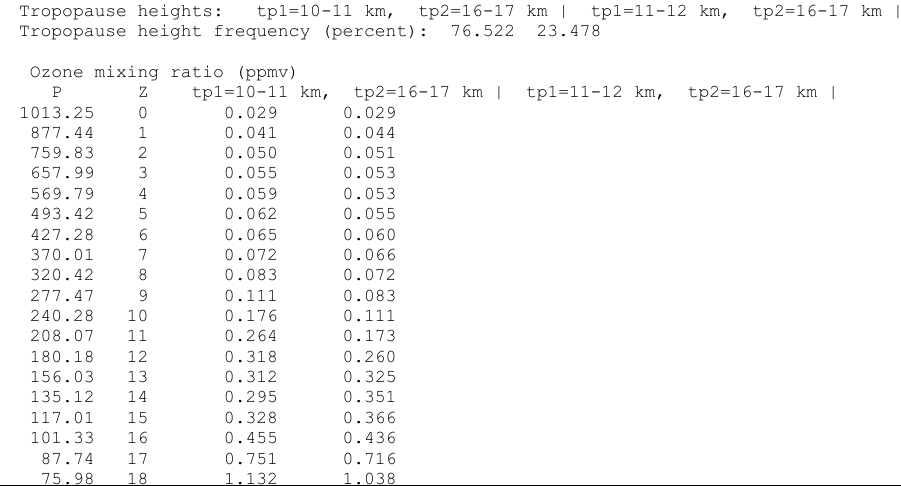
Fig. 16. An example of the records in the ASCII file for double-tropopause cases. “tp1” and “tp2” denote the first and the second tropopauses, respectively. After the ozone mixing ratio, values of the standard deviation are written in the